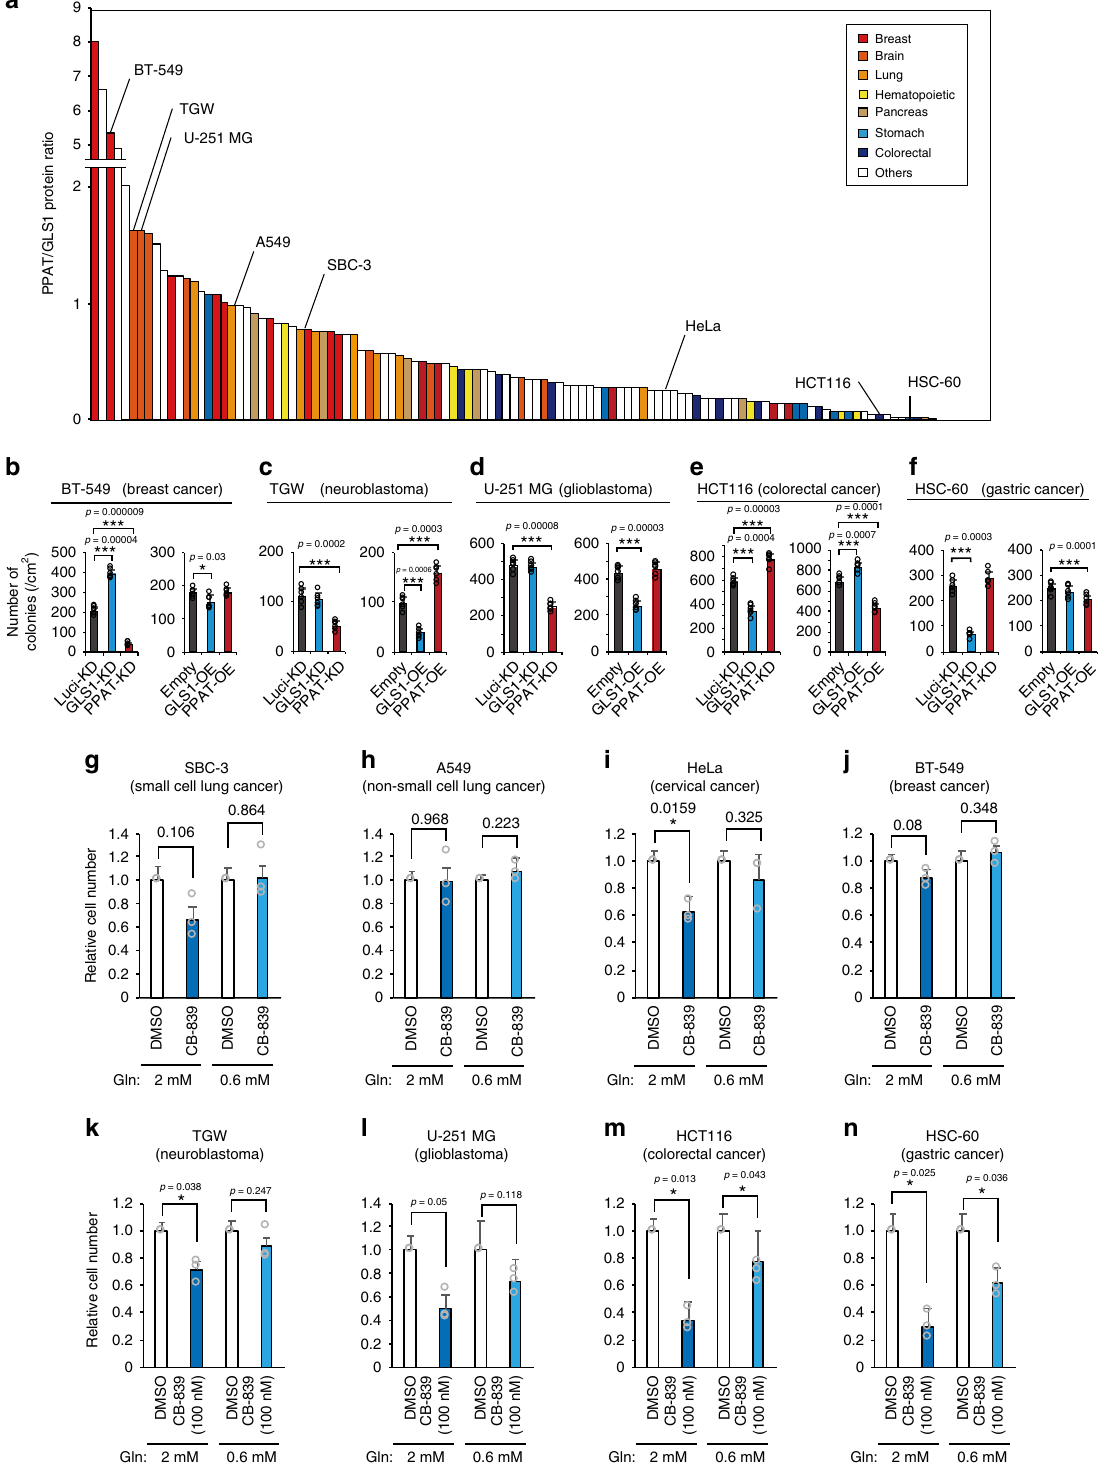
Fig. 5 Perturbation of the PPAT/GLS1 ratio in human cancer cell lines. a The PPAT/GLS1 ratio in 118 human cancer cell lines as determined by immunoblot analysis and densitometry. b – f Effects of knockdown (KD) or overexpression (OE) of GLS1 or PPAT on anchorage-independent growth were determined in the indicated cell lines ( n = 6). g – n Equal numbers of cells (5 × 10 5 ) of the indicated lines were plated and then cultured in medium containing 2 or 0.6 mM glutamine and in the presence of vehicle alone (DMSO) or 100 nM CB-839. Cell number was determined at 48 h and expressed relative to the corresponding value for the condition of 2 mM glutamine and DMSO ( n = 3). All colonies were counted in two randomly selected fi elds in each of three dishes. All cells were counted with three biological replicates. Data in b – n are means + s.d. * P < 0.05, ** P < 0.01, *** P < 0.001 (paired two- tailed Student ’ s t -test). Source data are provided as a Source Data fi